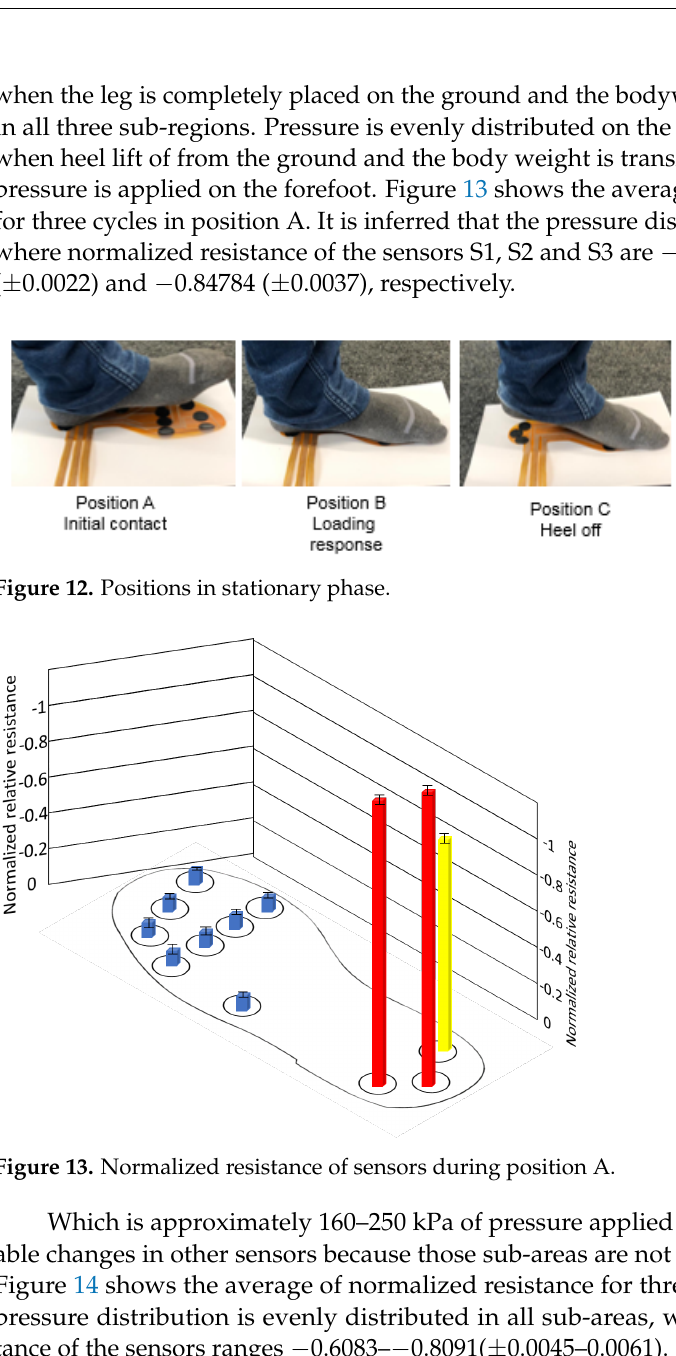
tance of the sensors ranges − 0.6083– − 0.8091( ± 0.0045–0.0061). The pressure distribution is approximately 70–90 kPa, 50–60 kPa, and 100–150 kPa in the heel, midfoot, and forefoot,